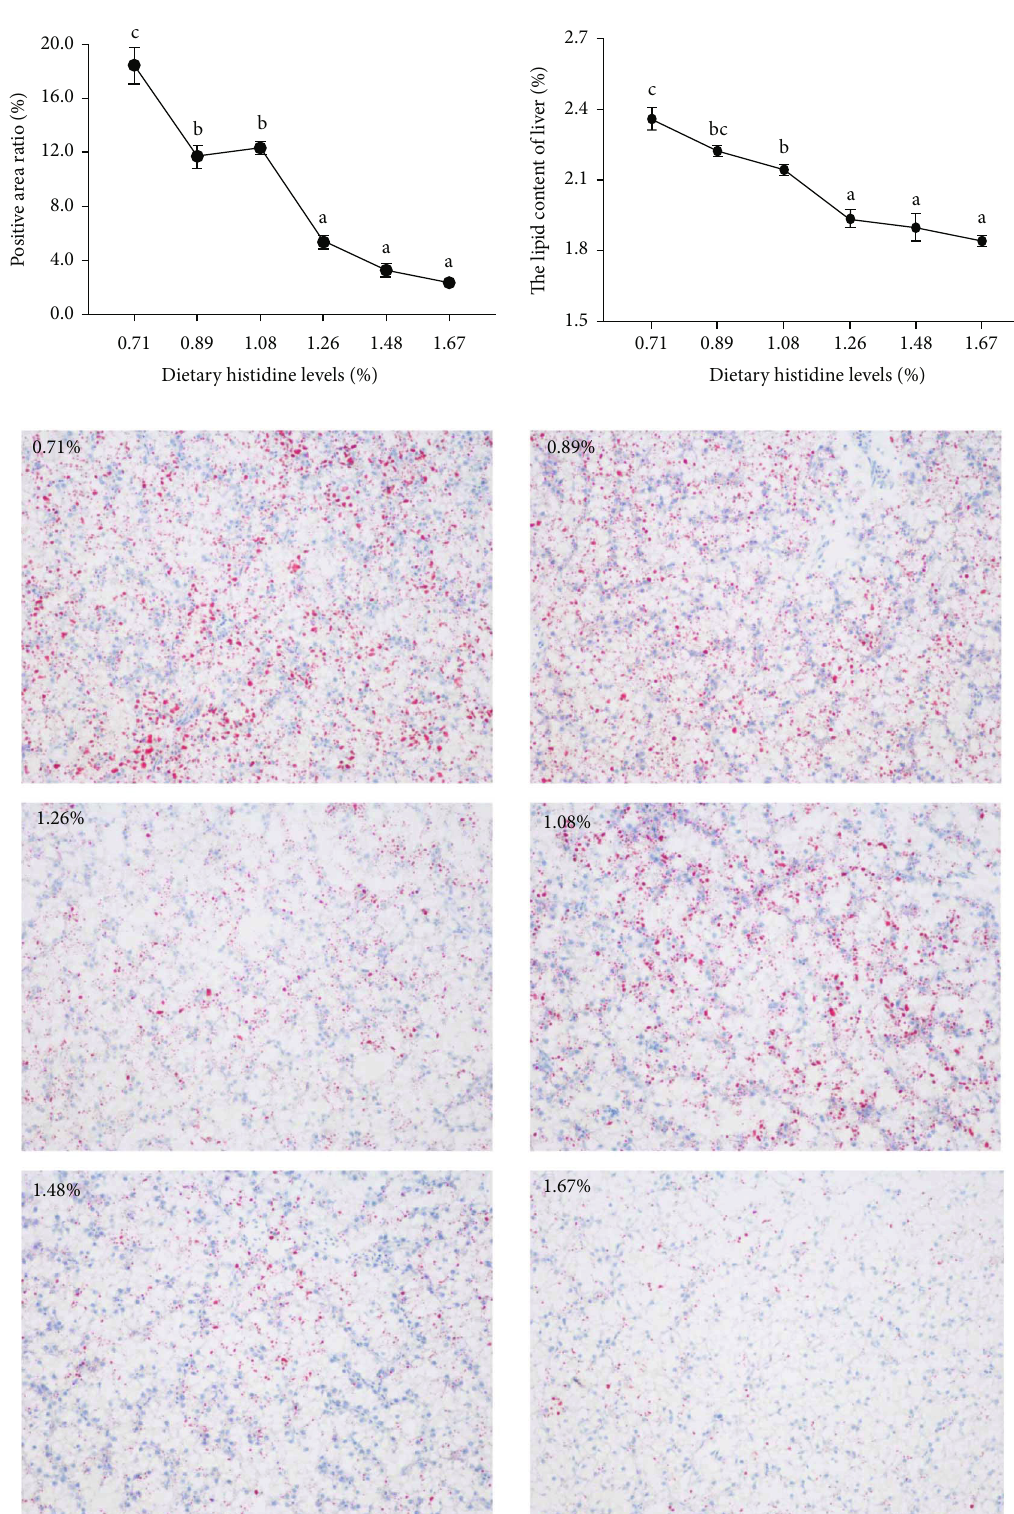
Figure 9: The hepatic oil red O staining and lipid content of juvenile largemouth bass fed with di ff erent levels of dietary histidine. Data are expressed as means with S.E.M.; value with di ff erent superscripts are signi fi cantly di ff erent ( P < 0 : 05